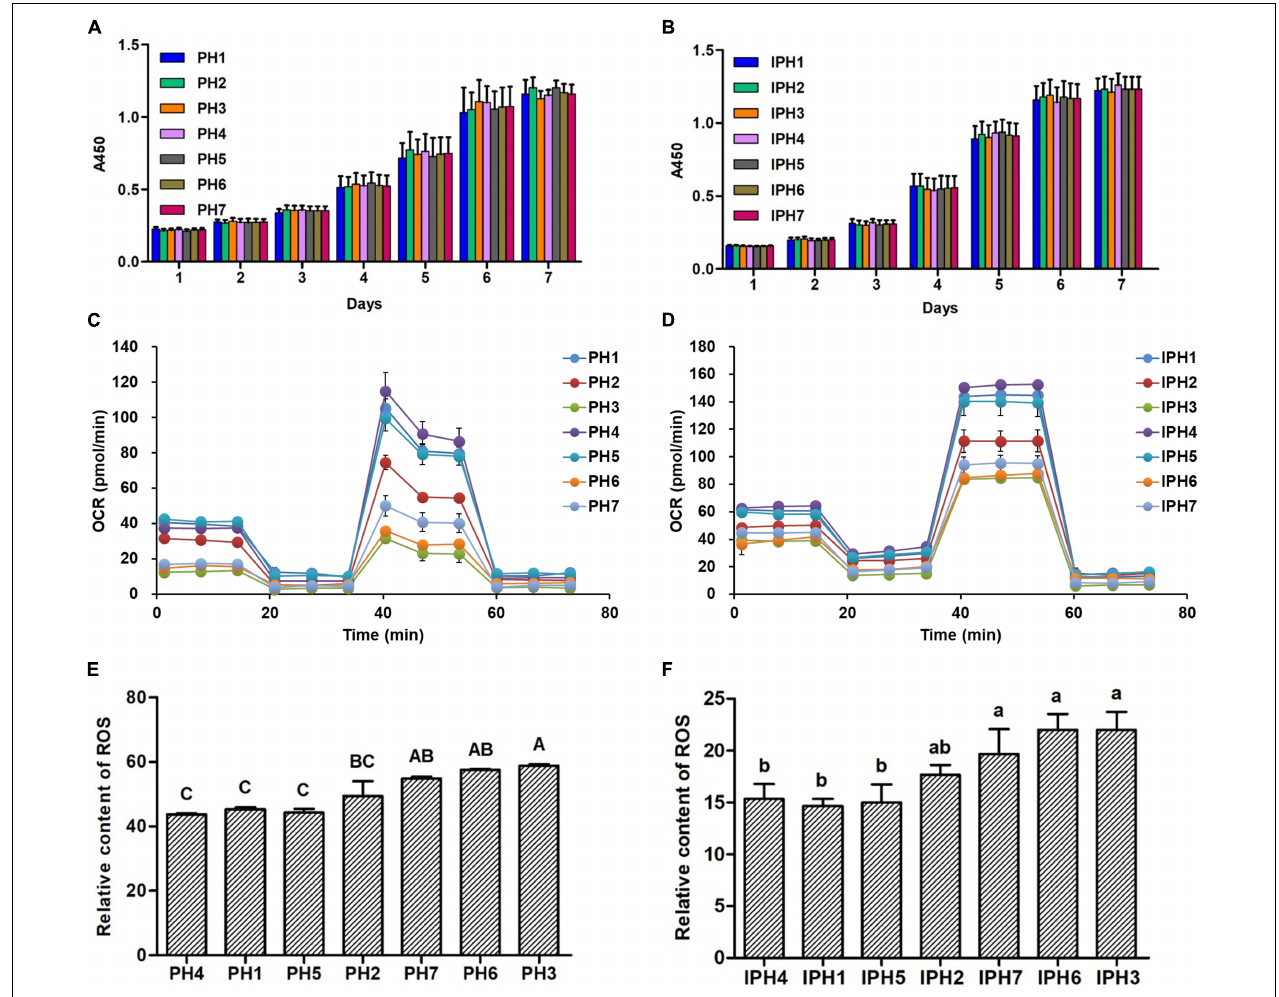
FIGURE 2 | Cell proliferation, oxygen consumption rate and ROS assays in different cell lines. (A) Cell proliferation in fibroblasts. (B) Cell proliferation in cybrids. (C) OCR assays for fibroblasts. (D) OCR assays for cybrids. (E) The relative ROS contents in fibroblasts. (F) The relative ROS contents in cybrids. Different capital or lowercase letters meant significant differences at P < 0.01 or P < 0.05, respectively. PH1-7, fibroblast with mitotype 1–7, respectively; IPH1-7, cybrid with mitotype 1–7,